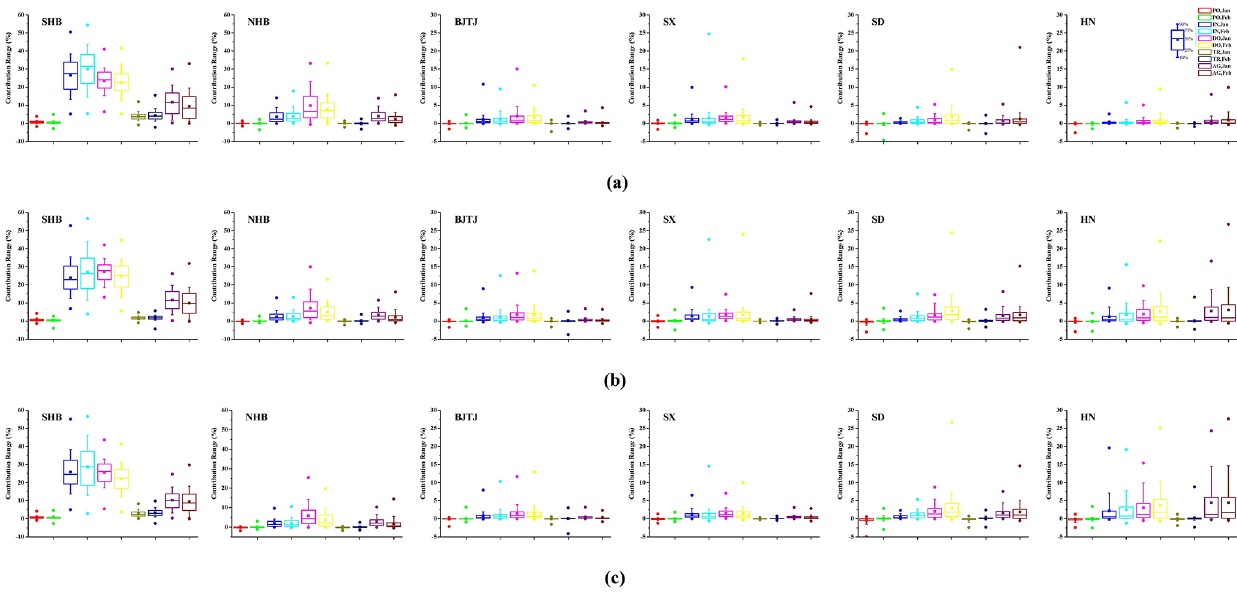
Fig. 11. Source contributions by region and sector to the PM 2 . 5 concentrations in (a) Shijiazhuang, (b) Xingtai, and (c) Handan from 14 January to February 2013. Dot signs indicate the maximum and minimum, and square signs indicate the average